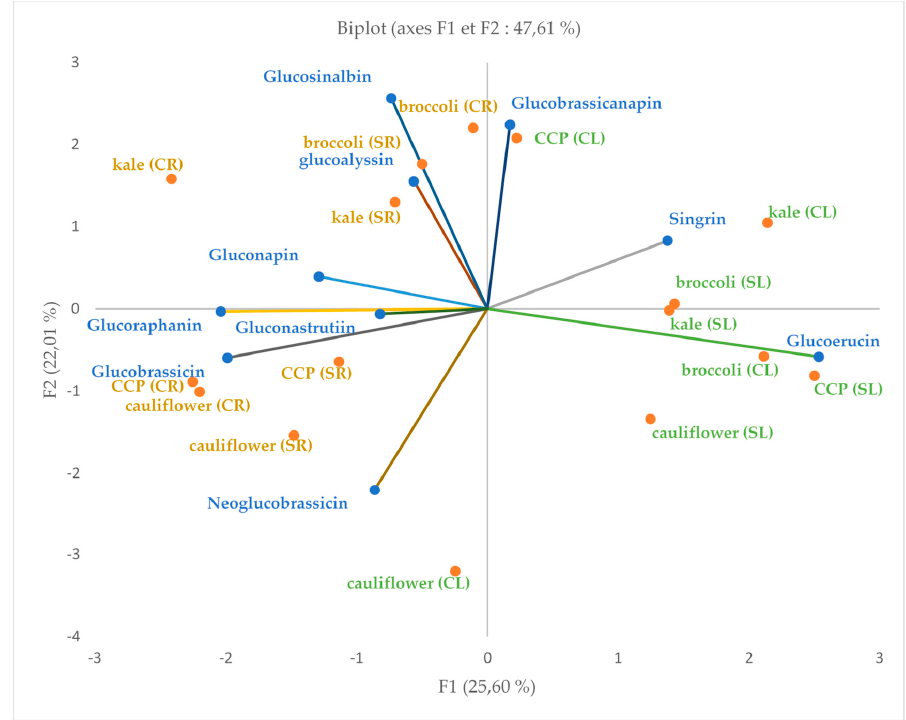
Figure 2. Two-dimensional principal component analysis (2D-PCA) of glucosinolates profile in leaves and roots. The first two principal component (PC) axes are labelled as PC1 and PC2, with the corresponding proportion of total variance in parentheses. SL: stressed leaves; CL: control leaves; SR: stressed roots; CR: control roots; different colors indicate various collard tissues (leaves in green and roots in brown). Kale (BH1, BH2, BH3); broccoli (BR1, BR2, BR3, BR4, BR5); cauliflower (CV1, CV2, CV3, CV4, CV5); composite cross population (CCP1, CCP2, CCP3, CCP4). 3.7. Variation of the Glucosinolates Compounds and Profile of the Leaves The leaves represent the products of kale and sprouting broccoli landraces; as for the latter ones, their products are traditionally represented in the Southern most Italian re- gions by their small heads and small tender leaves present around the inflorescence, which are collected and utilized for preparing typical dishes. For this reason, we analyzed the data registered to bring to light the variation in the GLSs content and profile in relation to water stress and to individuate the set of genotypes which could increase the nutraceu- tical value of the products. The correlation among the different GLSs detected in the leaves of the accessions of B. oleracea crops studied and their morphometric parameters was carried out to show the relation among the GLS profile and the GLS pathways variation in drought conditions (Table 4). The SIN showed a high negative correlation with the indolic glucosinolate NGBS (Table 5), as they had different metabolic pathways, so the biosynthesis of one af- fects the other. The aromatic glucosinolate SIB was positively correlated with the plant height (IH) and the GER showed a negative correlation with GAL and SIB. In addition, the GER showed a positive correlation with GST, and no other ones were observed with all the plant morphometric parameters detected (Table 5). A strong positive correlation was also observed between GBN and SIB and with the root weight (IRW) (Table 5). The GAL showed no correlation with all the glucosinolates detected, except for a significant positive correlation with the root weight (IRW) (Table 5). The positive correlation